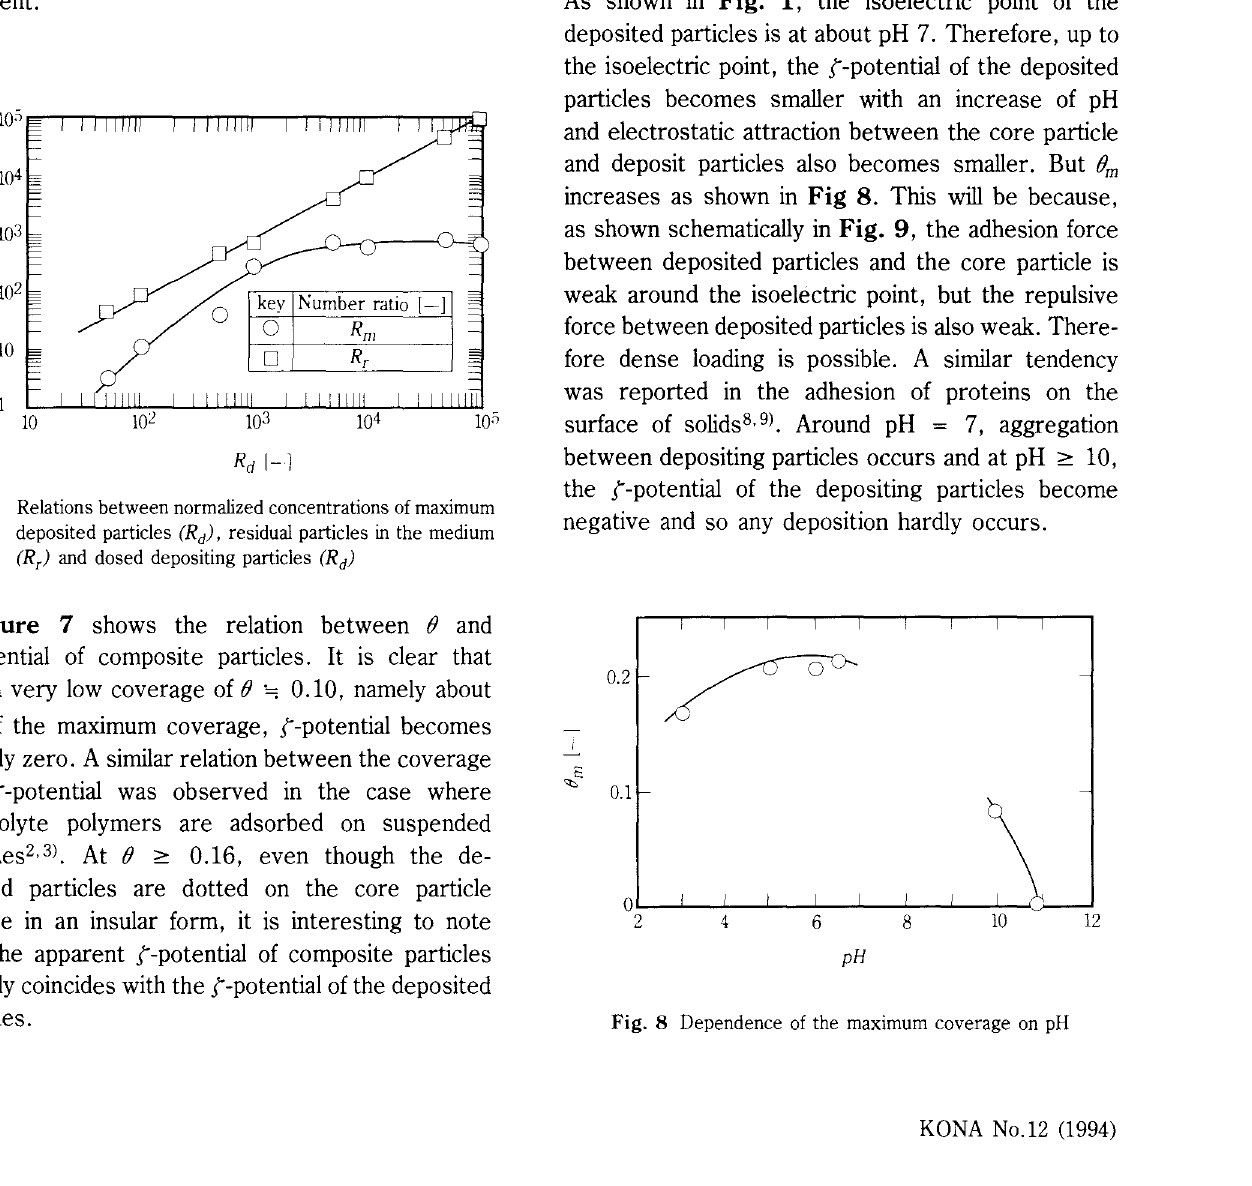
Fig. 7 Dependence of apparent on coverage